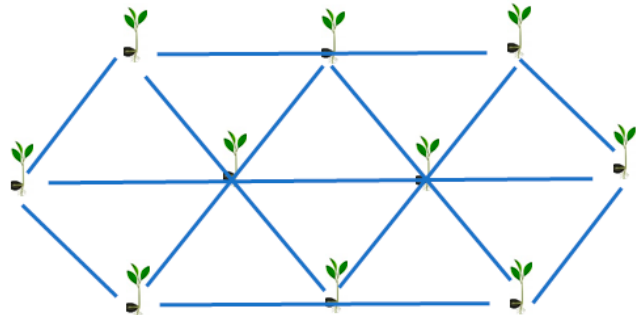
Figure 4. Triangular pattern of